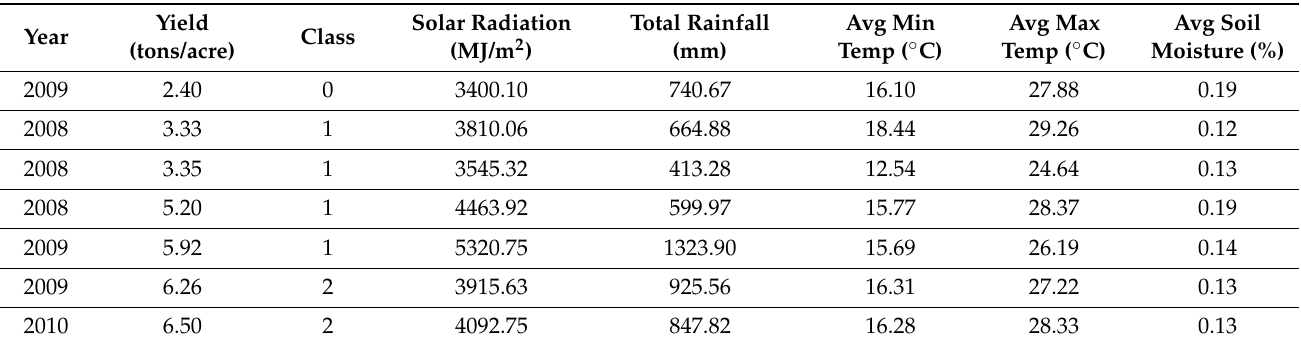
Table 1. Shows the five features used to train all KY and GA models plus year harvested and class, assigned according to standard deviation and yield; these are the 7 records in the very small GA target